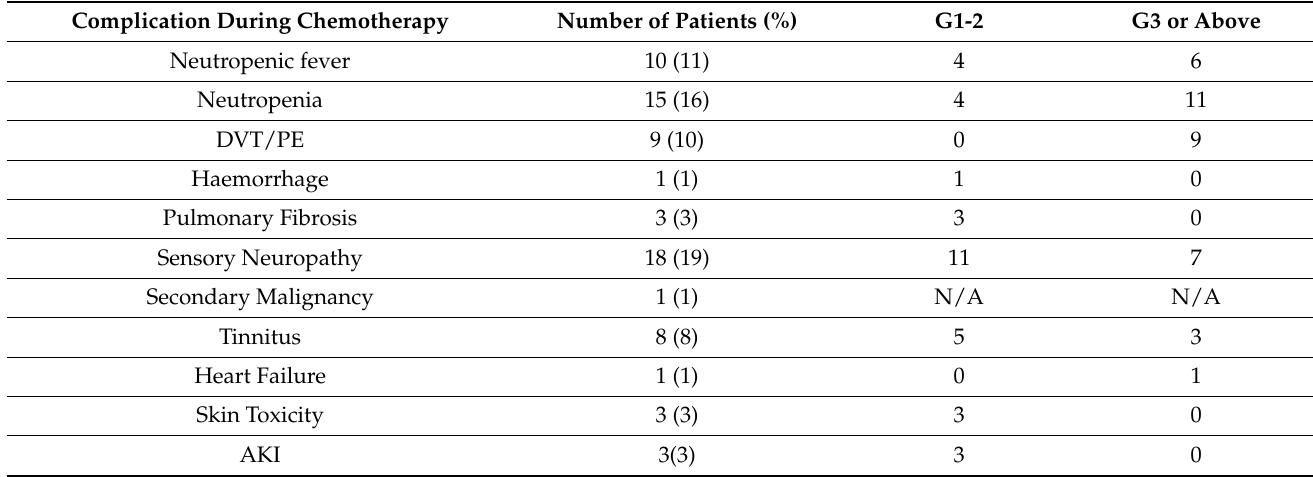
Table 3. Complications and adverse events during